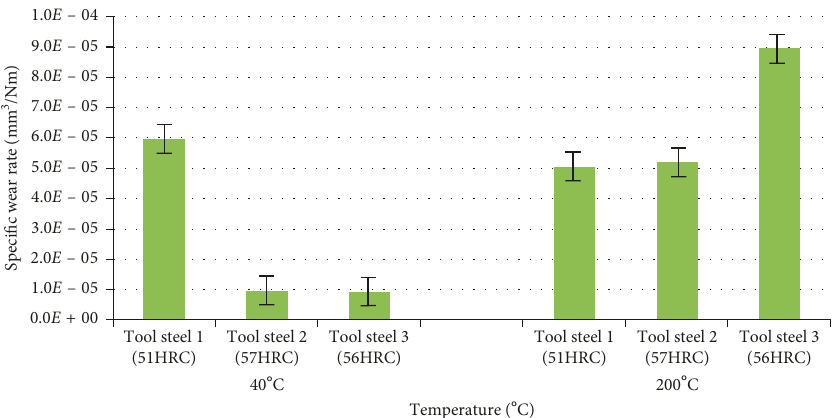
Figure 5: Specific wear rate of the disks at 40 ° C and 200 ° C.